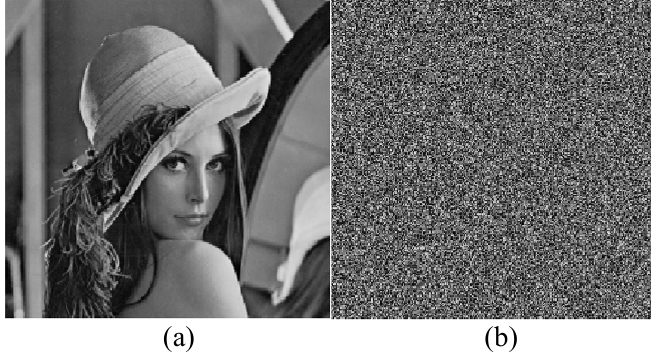
Figure 1. The security of the pseudo-random cyclic chain: ( a ) The original Lena image; ( b ) The reordering Lena